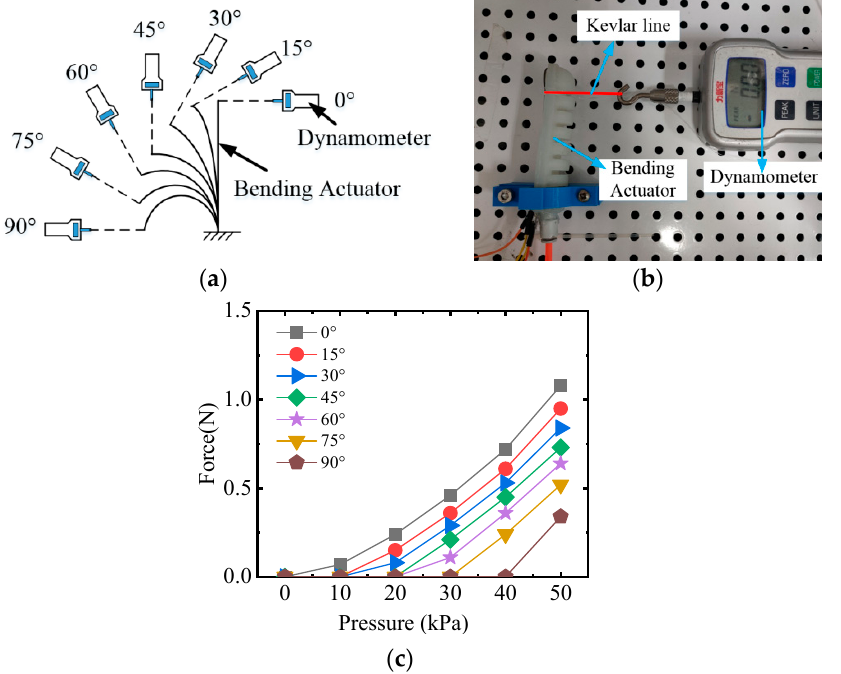
Figure 14. The force output test of the bending actuator. ( a ) Schematic diagram of the force test; ( b ) the force test device; and ( c ) bending angle of actuator. From the 0 ◦ initial position to the 90 ◦ position (with intervals of 15 ◦ ), the force